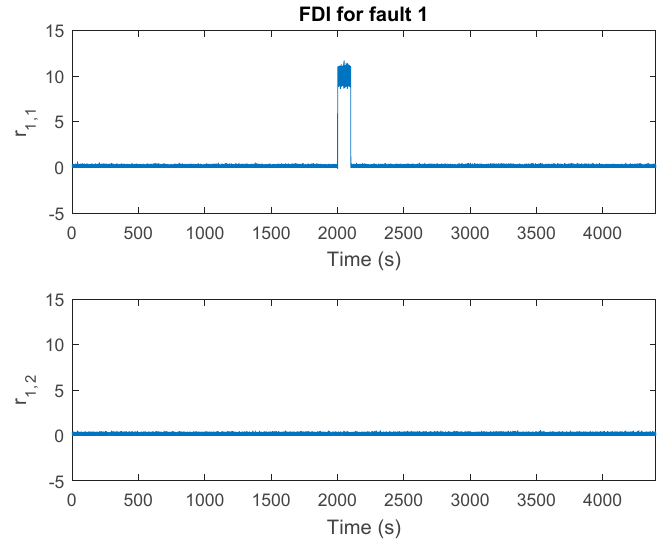
Figure 5. Faults in the first pitch system.